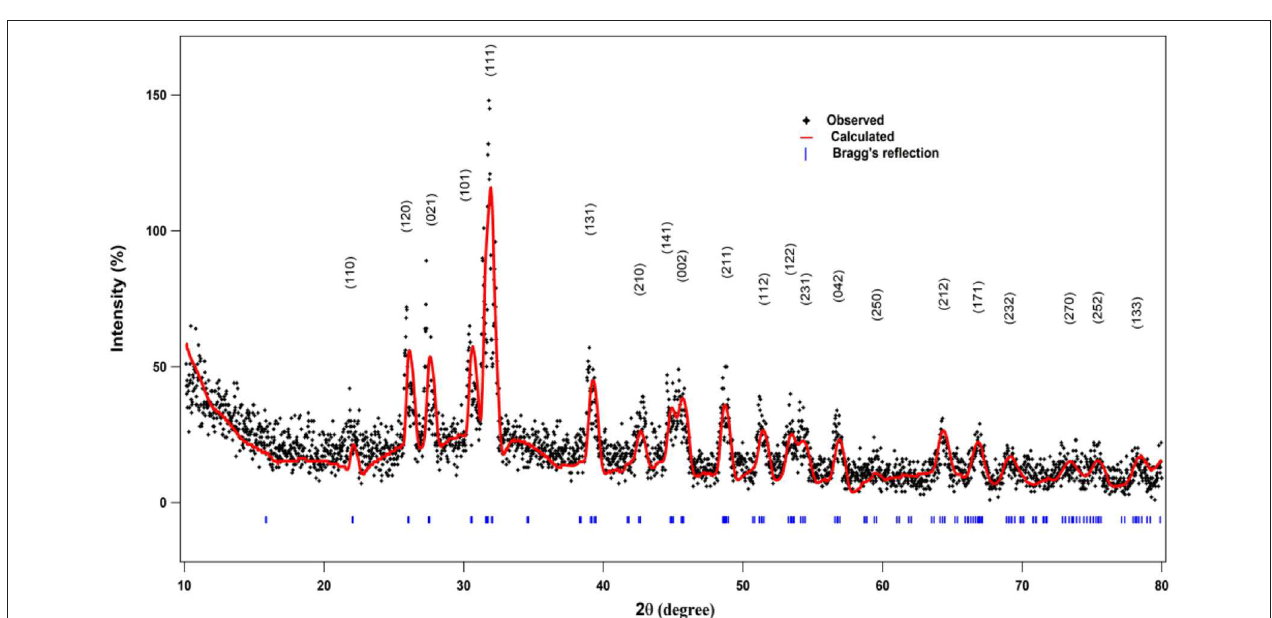
FIGURE 2 | XRD pattern of SnS